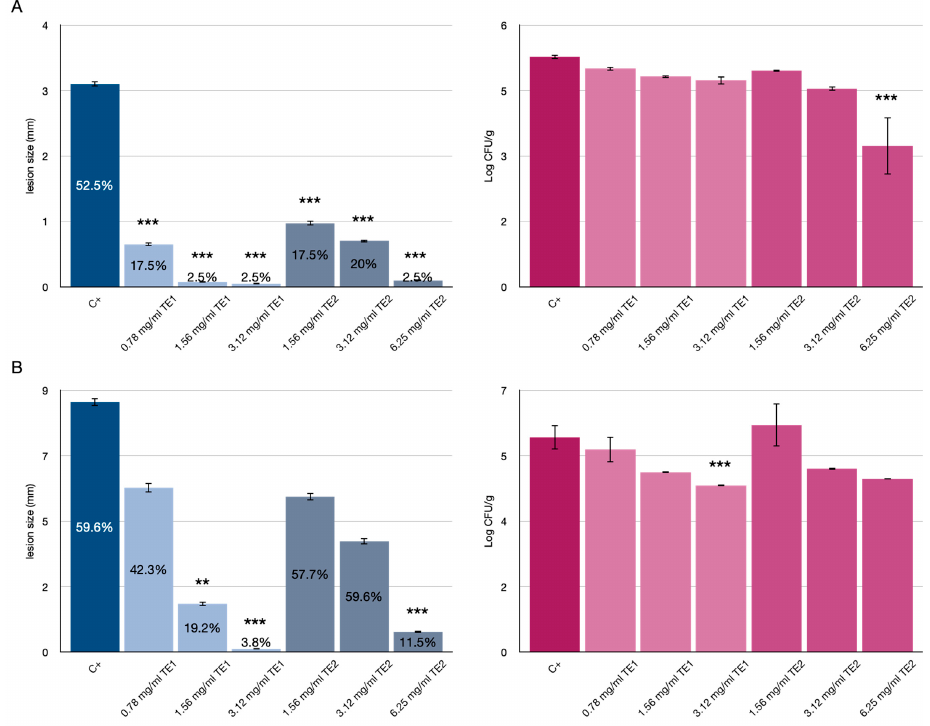
Figure 2. Effects of TE1 and TE2 on the growth of Fusarium graminearum in tomatoes. Results expressed as % infected fruit (IF), lesion size (mm) and microbiological count (log10 CFU/g) at 4 days ( A ) and 11 days ( B ). Statistically significant differences for each treatment are indicated by ** p < 0.01, *** p < 0.001. Results are expressed as mean ± standard error.